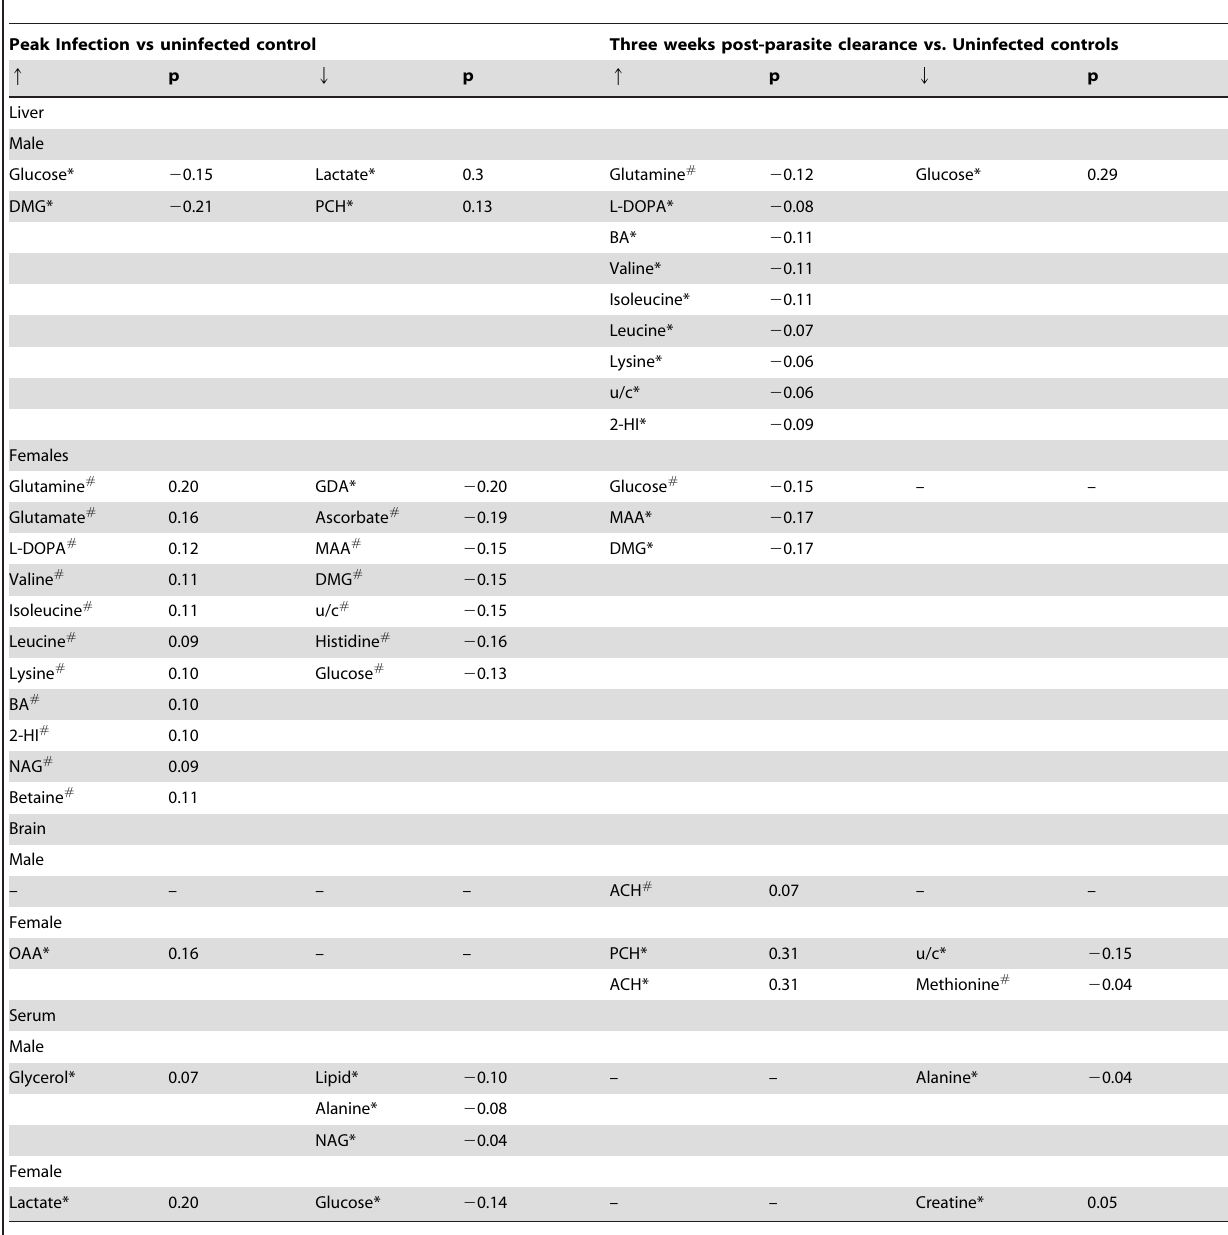
Peak Infection vs uninfected control Three weeks post-parasite clearance vs. Uninfected